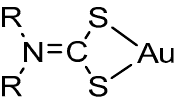
Figure 2 . The dominant resonance form of a dithiocarbamate complex.